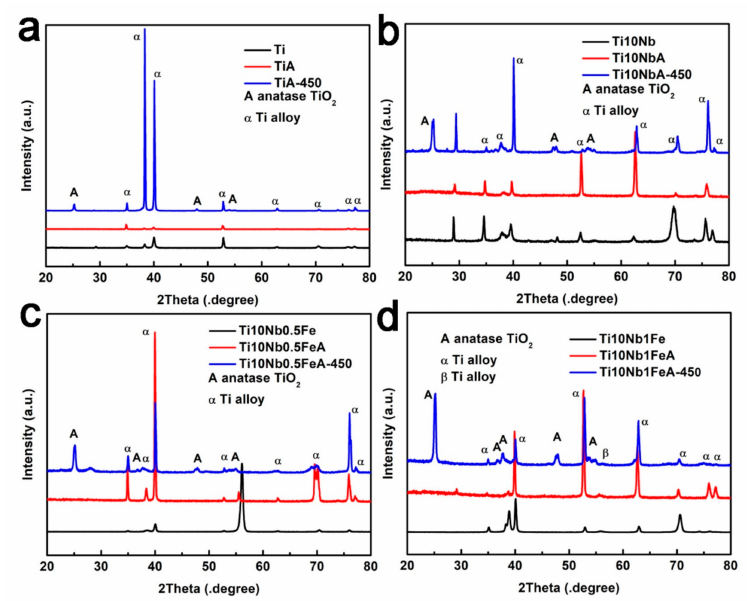
Figure 7. XRD patterns of Ti ( a ), Ti10Nb ( b ), Ti10NbxFe ( c , d ) alloys and